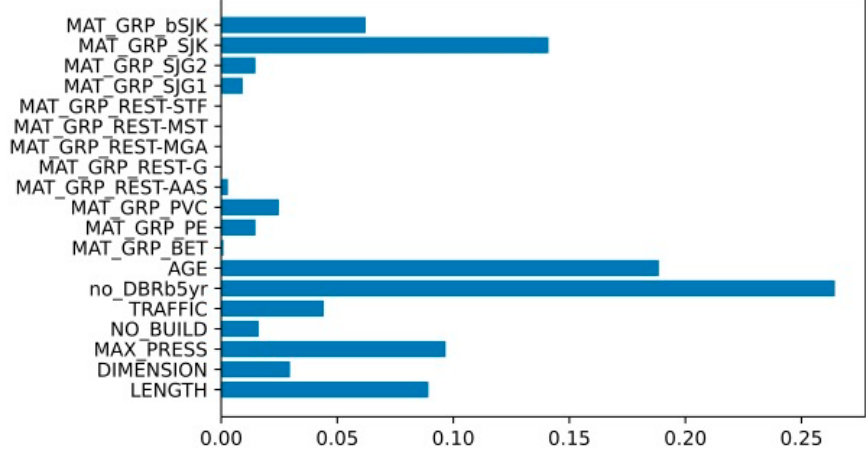
Figure A5. Schematic of pipe failure prediction by Random Forest.